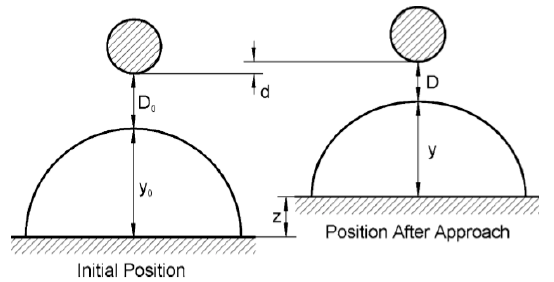
Figure 2. Schematic of bubble-particle interaction in AFM system [15].